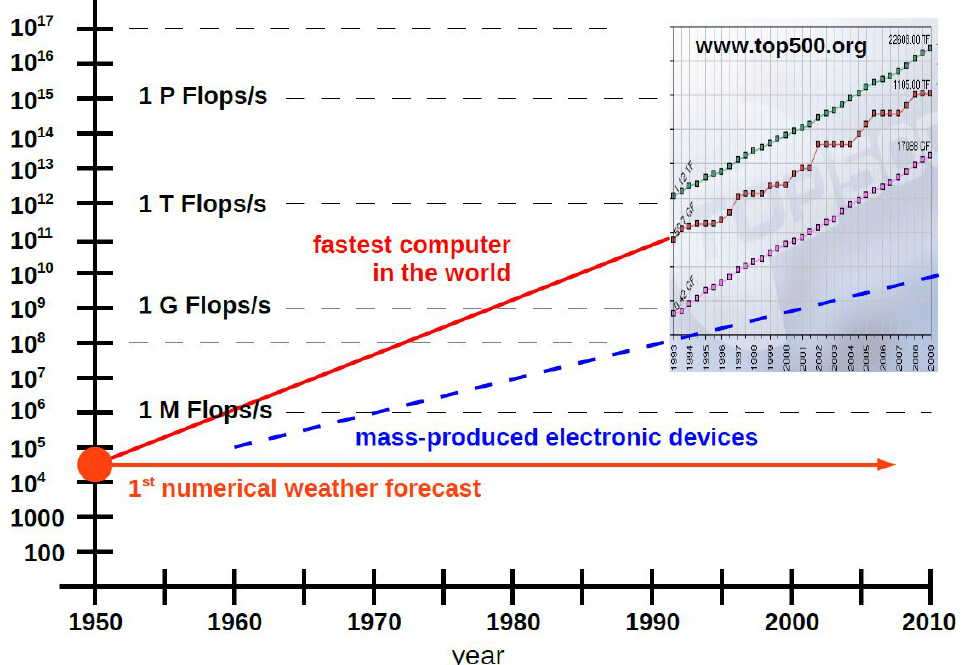
Figure 6. Performance of computational devices (in floating point operations (Flops) per second) over time from [72] (upper right inlay) extrapolated back to 1950 when the first numerical weather forecast (24 h forecast time, 24 h computation) has been performed [73]. The similar increase in computational performance of mass-produced electronic devices (dashed blue line) enabled Lynch and Lynch [74] to repeat this 1st 24 h weather forecast (as Java application) on a customary cell phone in less than 1